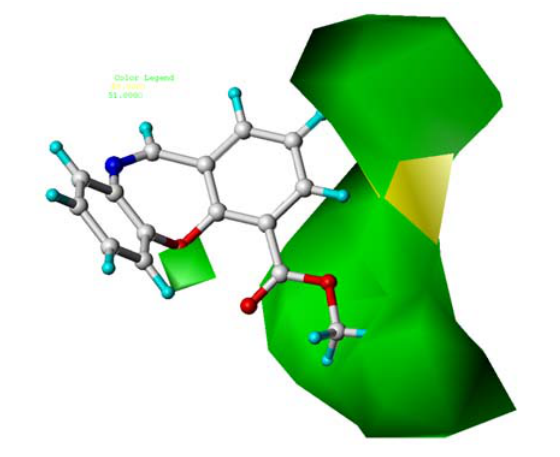
Figure 5. Contour maps of CoMSIA steric region in combination with compound 10 . Steric fields: green contours (51% contribution) indicate regions where bulky groups increase activity, while yellow contours (48% contribution) indicate regions where bulky groups decrease activity. Compound 10 is depicted in ball and stick representation, coloured by atom type (white C, blue N, red O, cyan H)